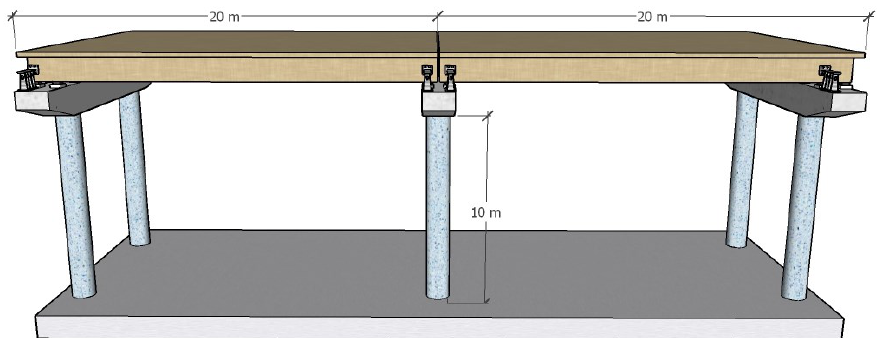
Figure 15. Bridge Figure 15. Bridge prototype.